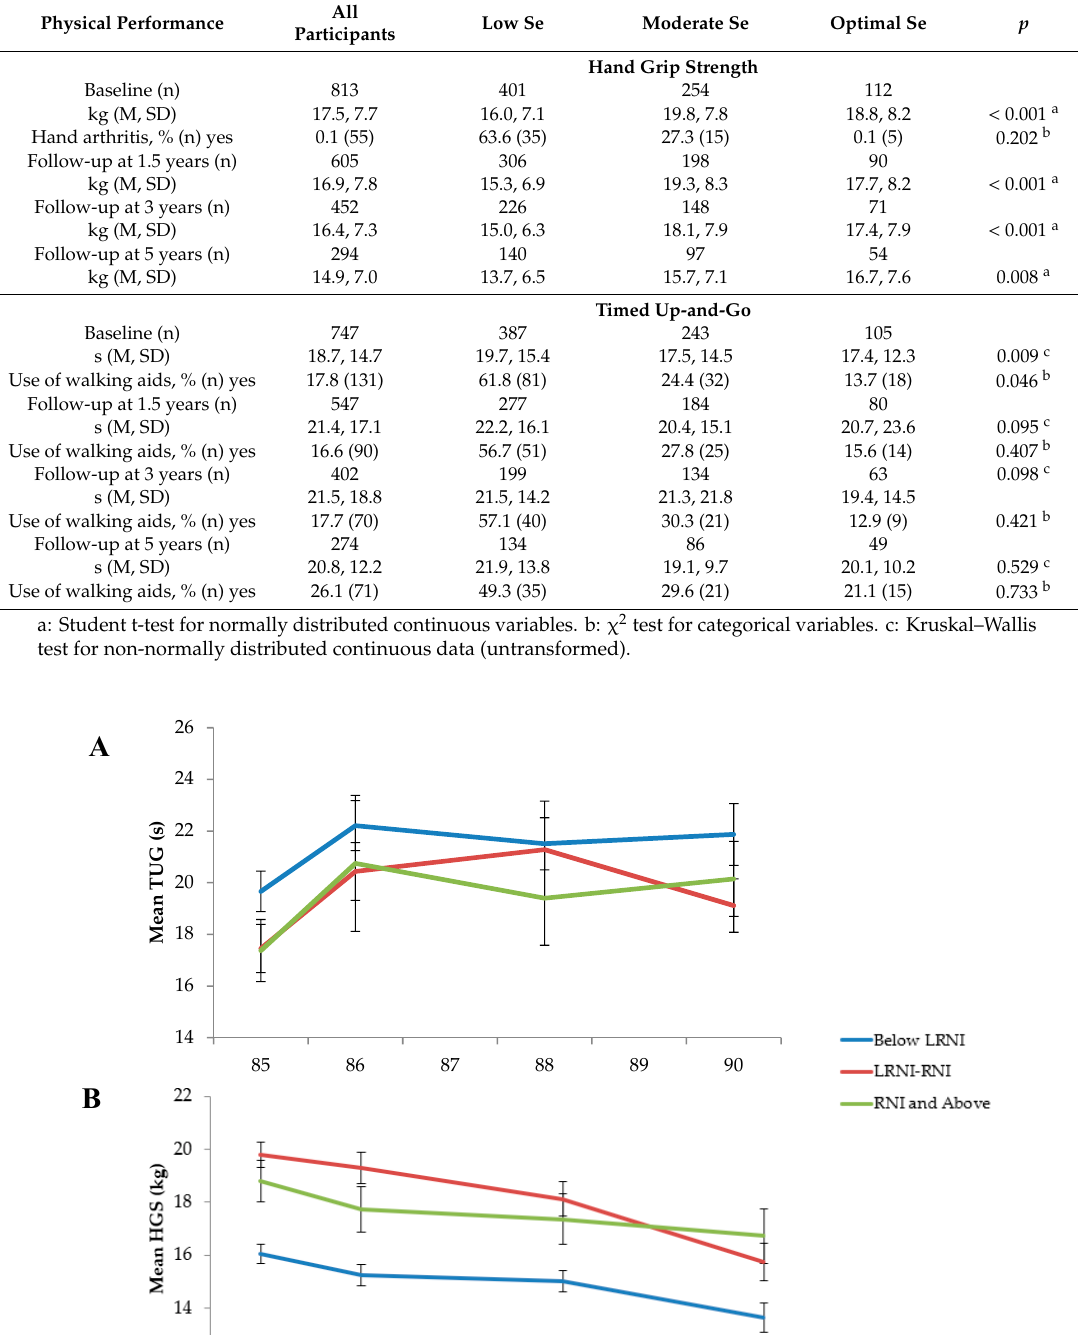
Table 3. Untransformed hand grip strength and timed up-and-go scores by selenium intake groups at baseline and follow-up.